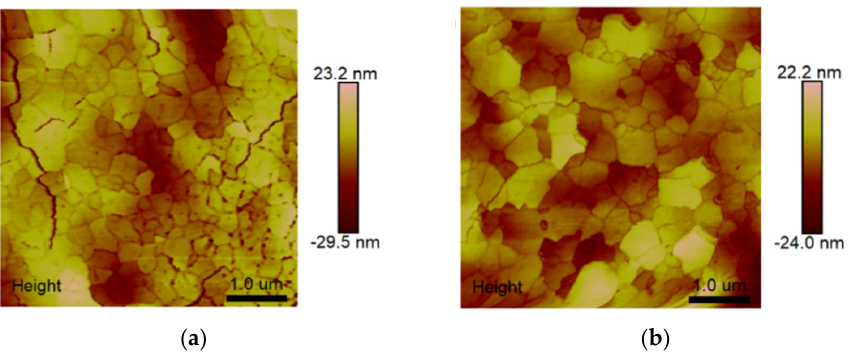
Figure 2. Surface morphology of (BA) 2 MA 3 Pb 4 I 13 with ( a ) preheating at 90 °C and ( b ) preheating at 100 °C.